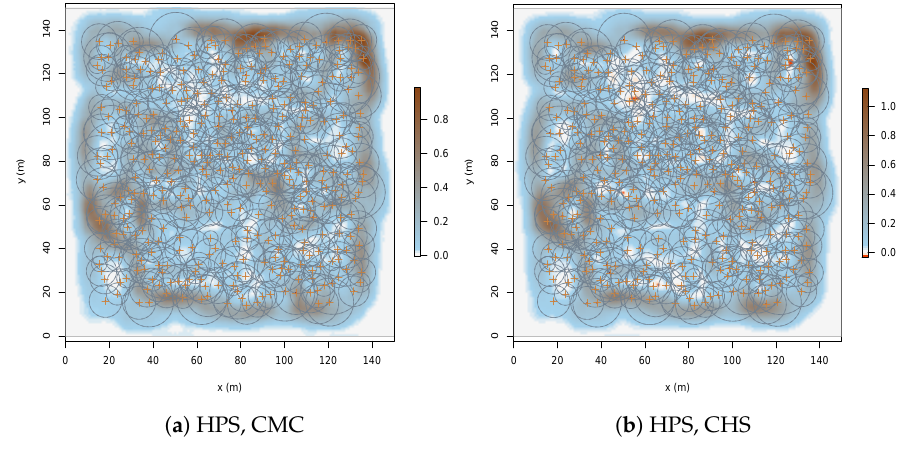
= 8 m showing Cov ( X , Y ) with ( a ) X = HPSbaf3 4